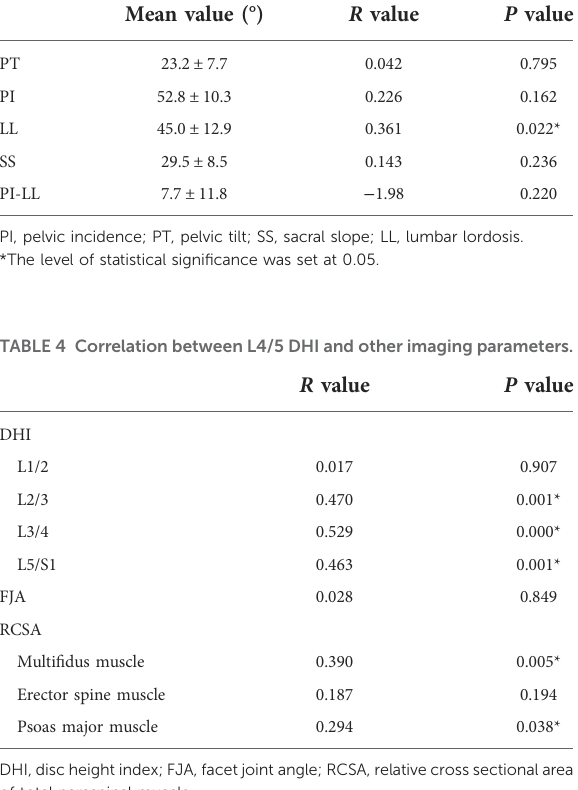
TABLE 2 Comparison of FJA in the two groups ( x ±s).